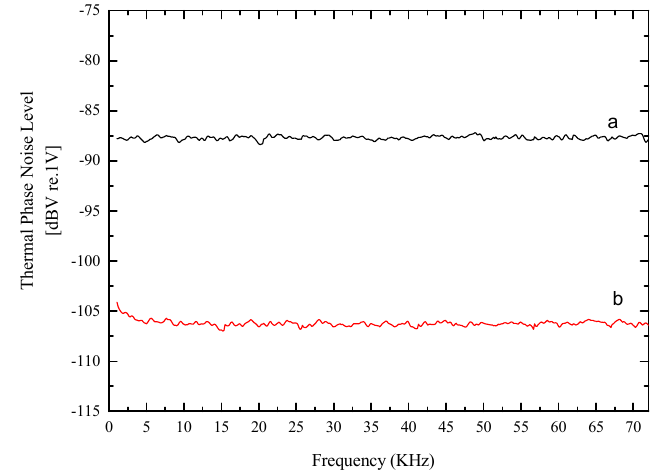
Figure 4. The output signals without phase modulation from spectrum analyzer: without noise subtraction (curve a), with noise subtraction (curve b).